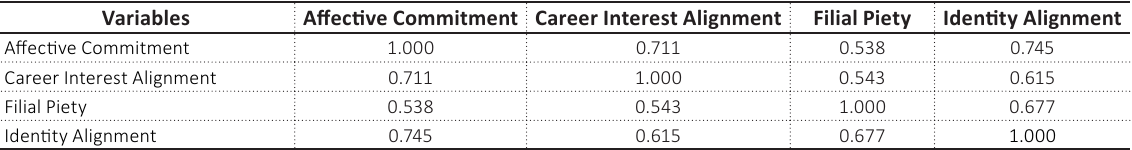
Table 4. Latent variables’ correlation